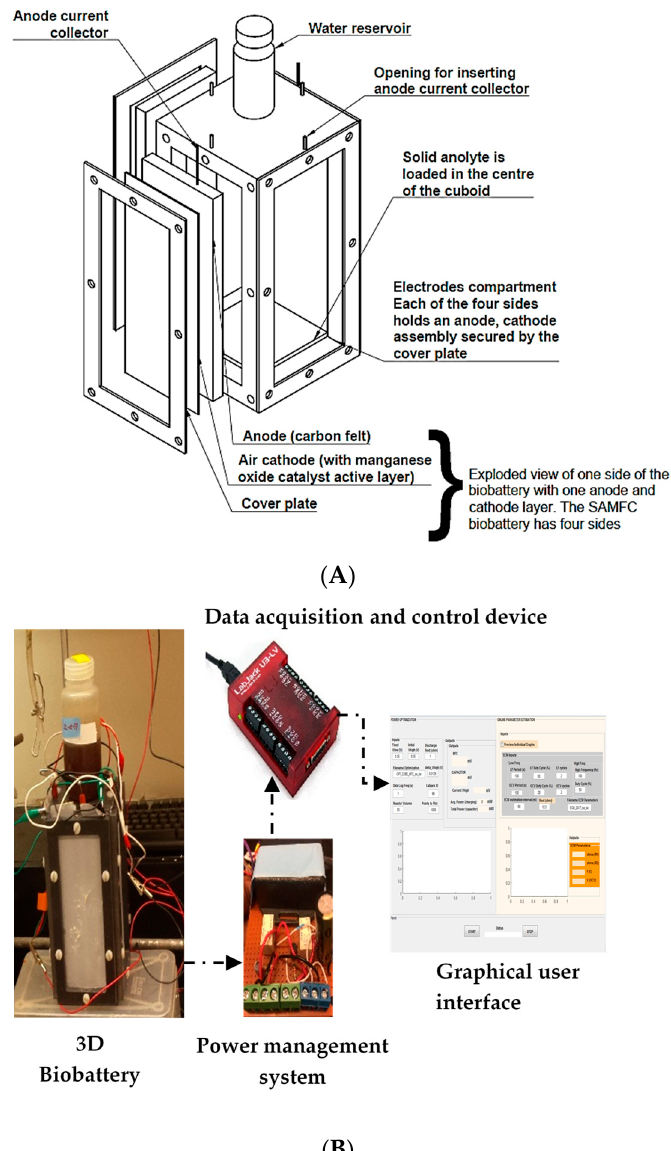
Figure 1. Schematic diagram of a SA-MFC biobattery ( A ); pictures of the assembled setup ( B ). Figure 1. ( A ) Schematic diagram of a SA-MFC biobattery; ( B ) pictures of the assembled